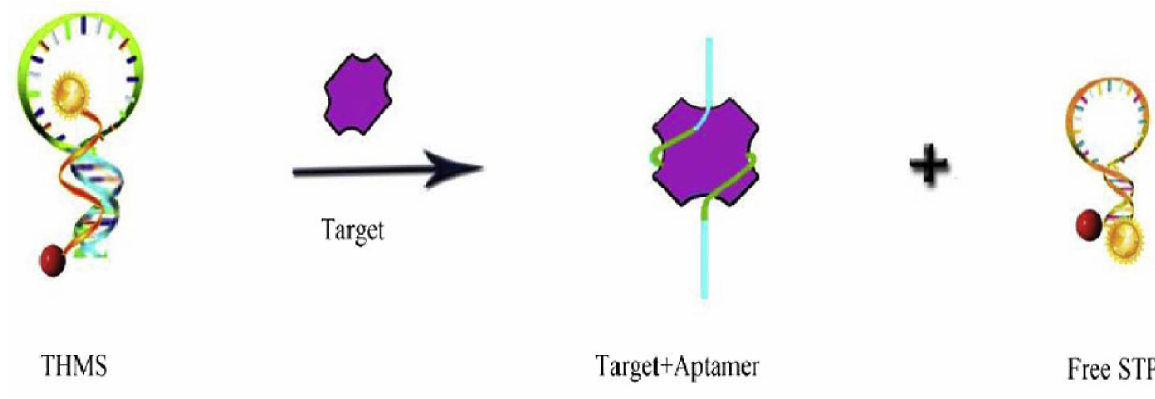
Figure 3. Schematic illustration of the conformation change of the Triple-helix molecular switch (THMS) structure in the presence of the target Reprinted from reference [26] with permission from